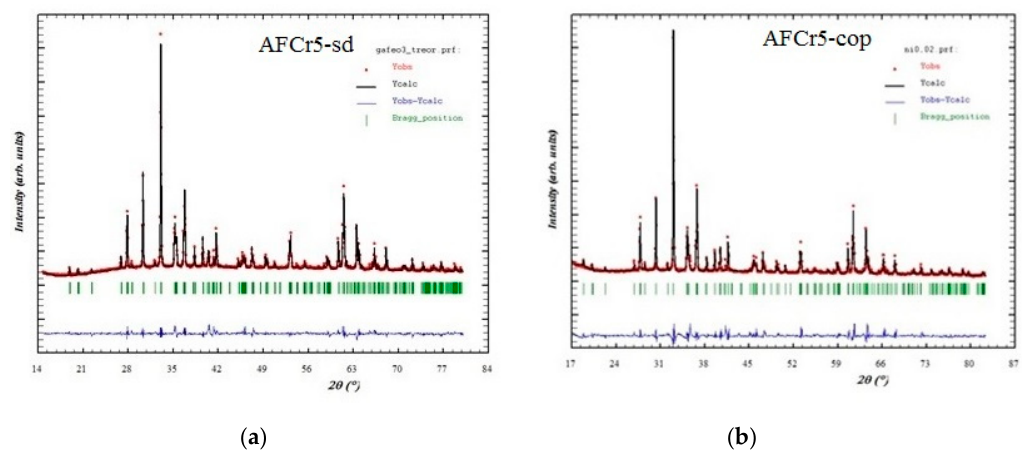
Figure 1. Rietveld refinement of samples X-ray diffraction (XRD) pattern ( a ) AFCr5-sd ( b ) AFCr5-cop.